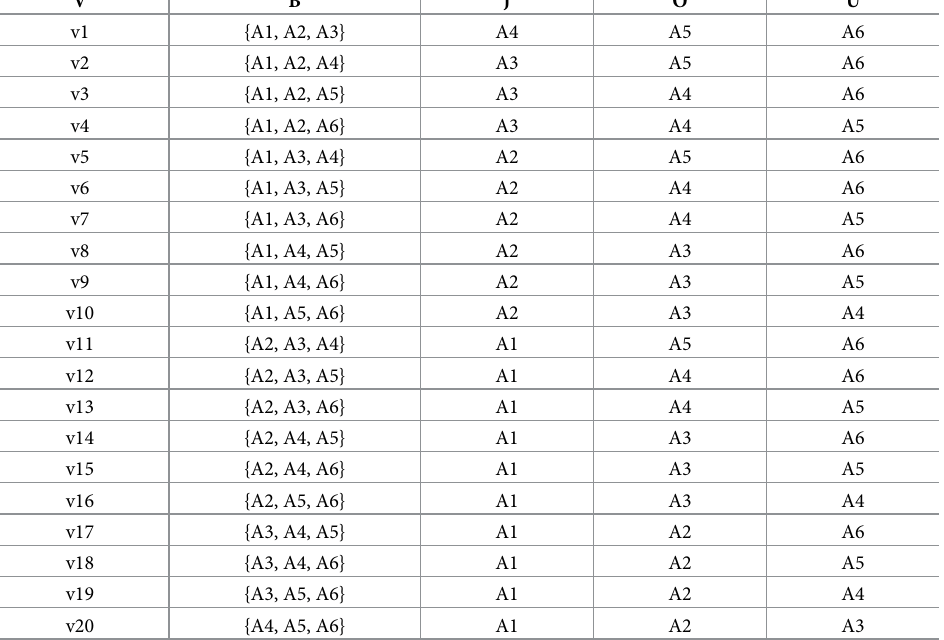
Table 2. Twenty possible groups representing different combined patterns of residues which are described using 4 letters B, J, O, and U. V